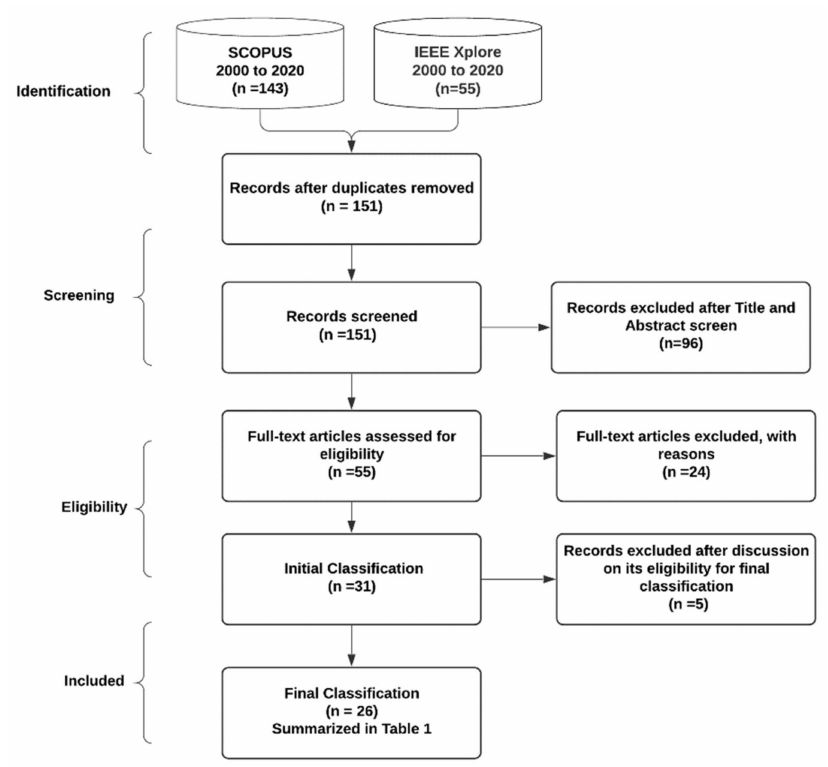
Figure 2. Phase I: Supply Chain Risk Management in the Apparel Industry Outsourcing research papers selection